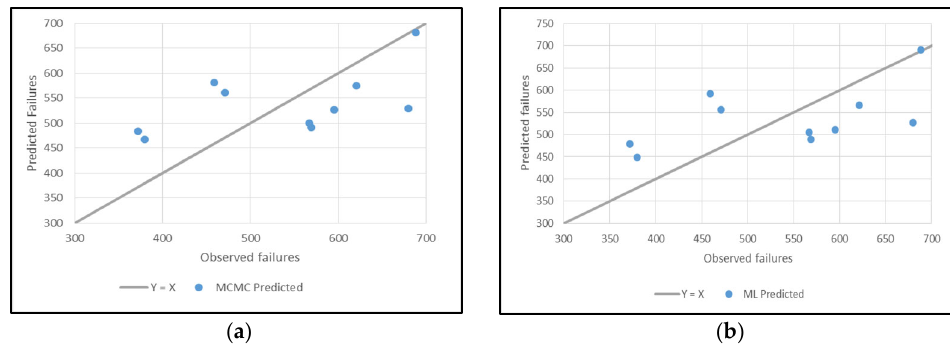
Figure 9. Pair plot of observed and predicted failures. ( a ) MCMC estimation; ( b ) ML estimation.